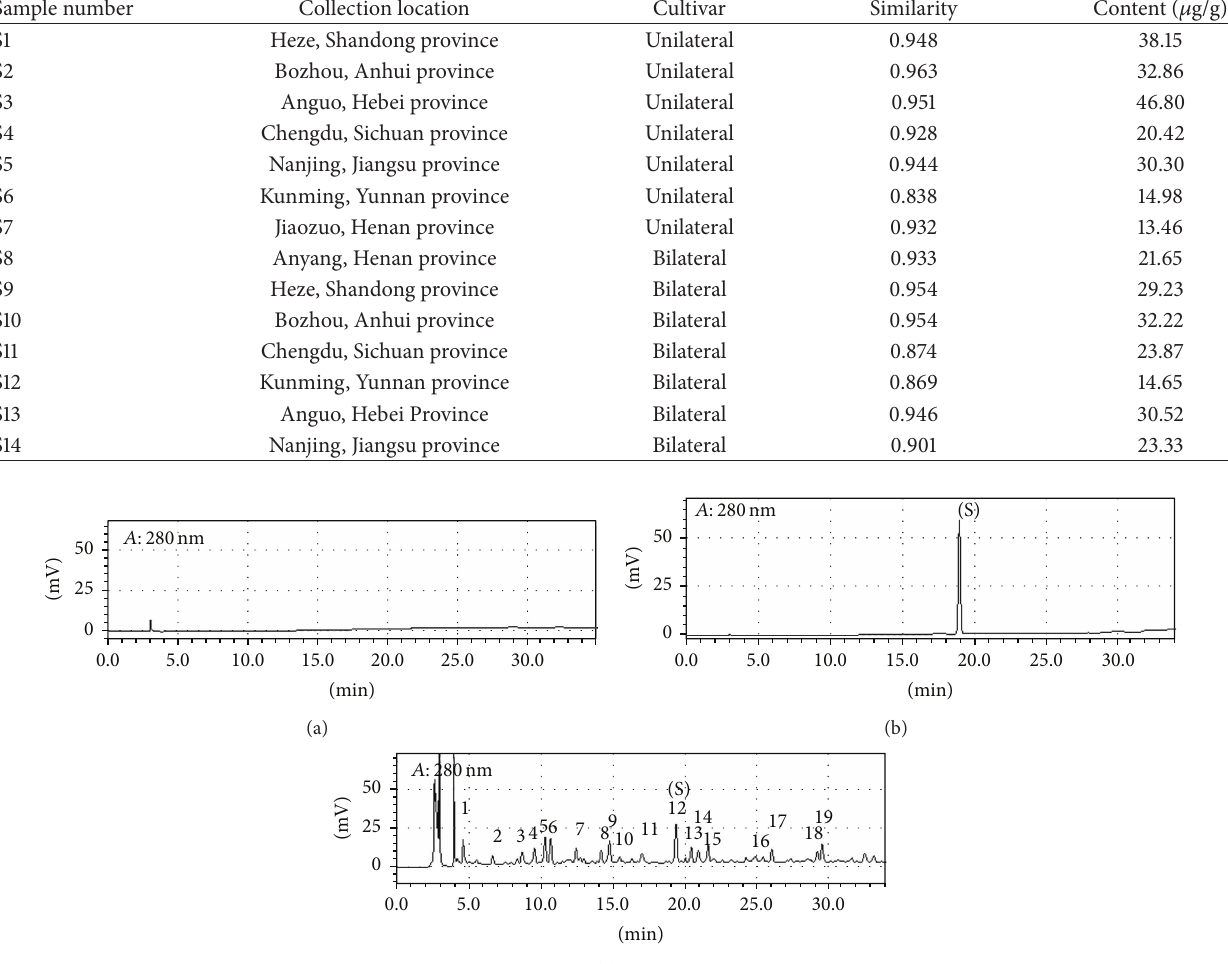
Figure 3: Standardized HPLC chromatographic fingerprints. (a) Negative control. (b) Isovanillin control. (c) Experimental